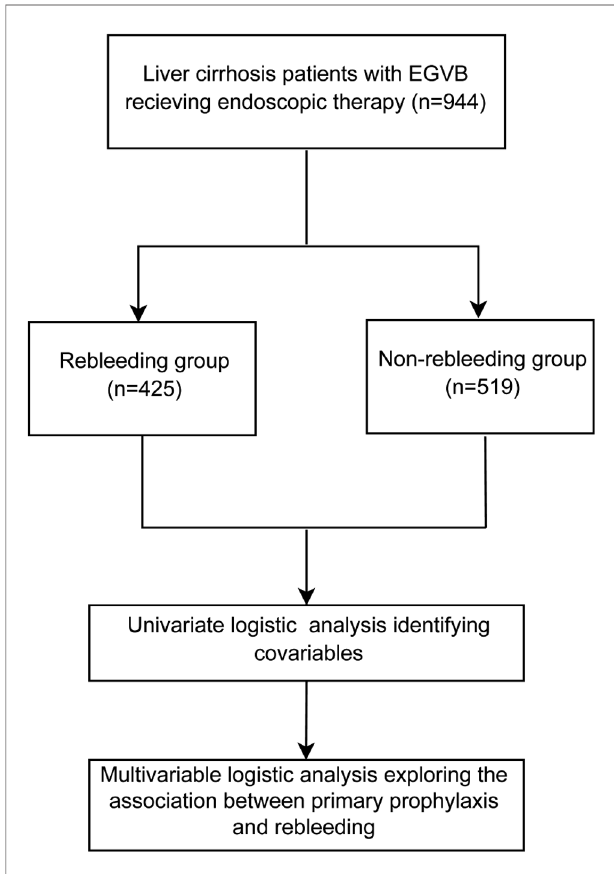
FIGURE 1 | The analysis process of our